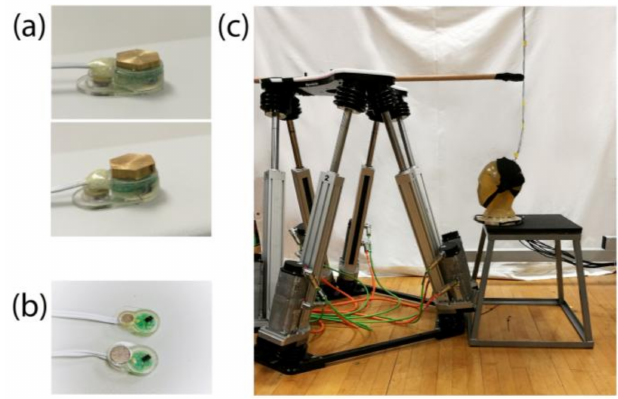
Figure 2. ( a ) Brass pieces used to double (top) and triple (bottom) the mass of the electrode for the electrode mass experiment; ( b ) the electrodes used for the surface area experiment. The standard unmodified electrode with the smaller surface area next to the modified electrode with the larger surface area; ( c ) setup of the cable sway experiment. The phantom was detached from the motion hexapod and was placed next to it. We secured a wooden rod on the motion hexapod and performed horizontal sinusoidal displacements to move the